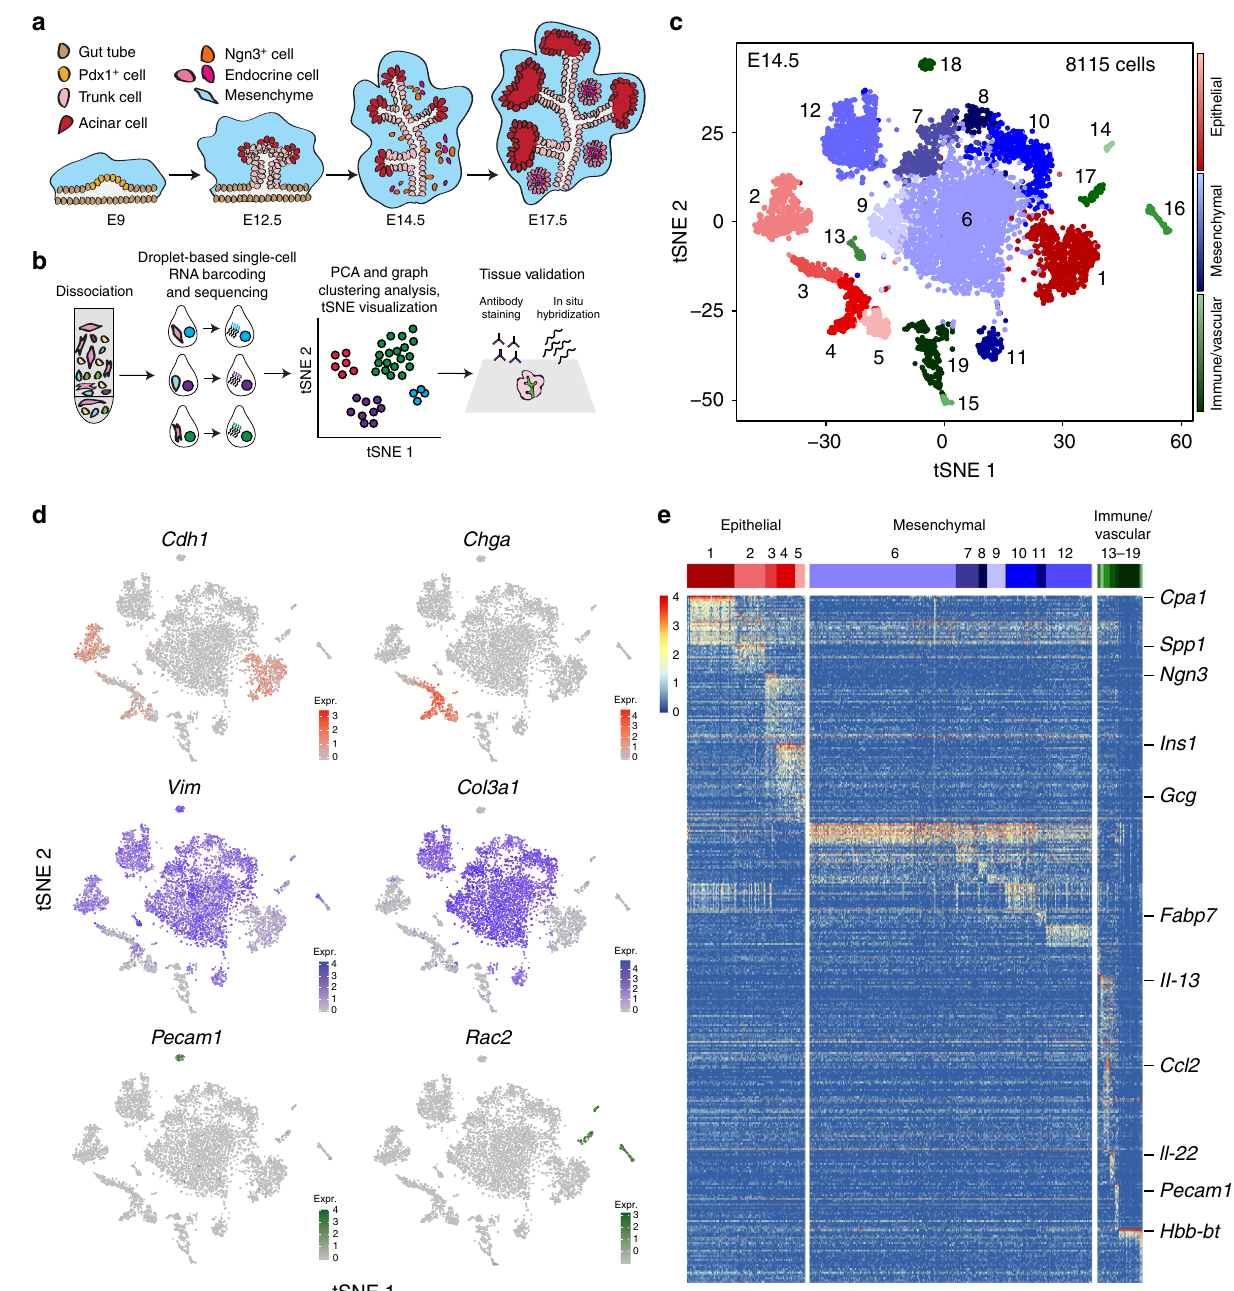
Fig. 1 Single-cell sequencing identi fi es broad patterns of cellular heterogeneity in E14.5 murine pancreas. a Overview of murine pancreatic development. b Schematic of experimental approach. c t-Distributed stochastic neighbor embedding (t-SNE) visualization of populations from pooled E14.5 mouse pancreata ( n = 14). Each dot represents the transcriptome of a single cell, color-coded according to its cellular identity (epithelial, mesenchymal, or immune/vascular). Each cell compartment contains multiple subpopulations, represented by varying degrees of color shading. d Established marker genes identify epithelial cells (Cdh1 + ), endocrine cells (Chga + ), mesenchymal cells (Vim + and Col3a1 + ), endothelial cells (Pecam1 + ), and immune cells (Rac2 + ). e Heatmap depicting greater than two-fold differentially expressed genes in each cluster compared to all other clusters. Cells are represented in columns, and genes in rows. Speci fi c genes used to annotate clusters are indicated to the right of the